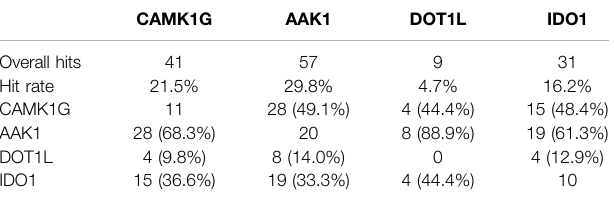
TABLE 2 | Overall hits and hit rates for all targets. A matrix of unique and mutually binding fragment hits is appended. Percentages are provided with respect to the total number of hits for the target in the respective column.